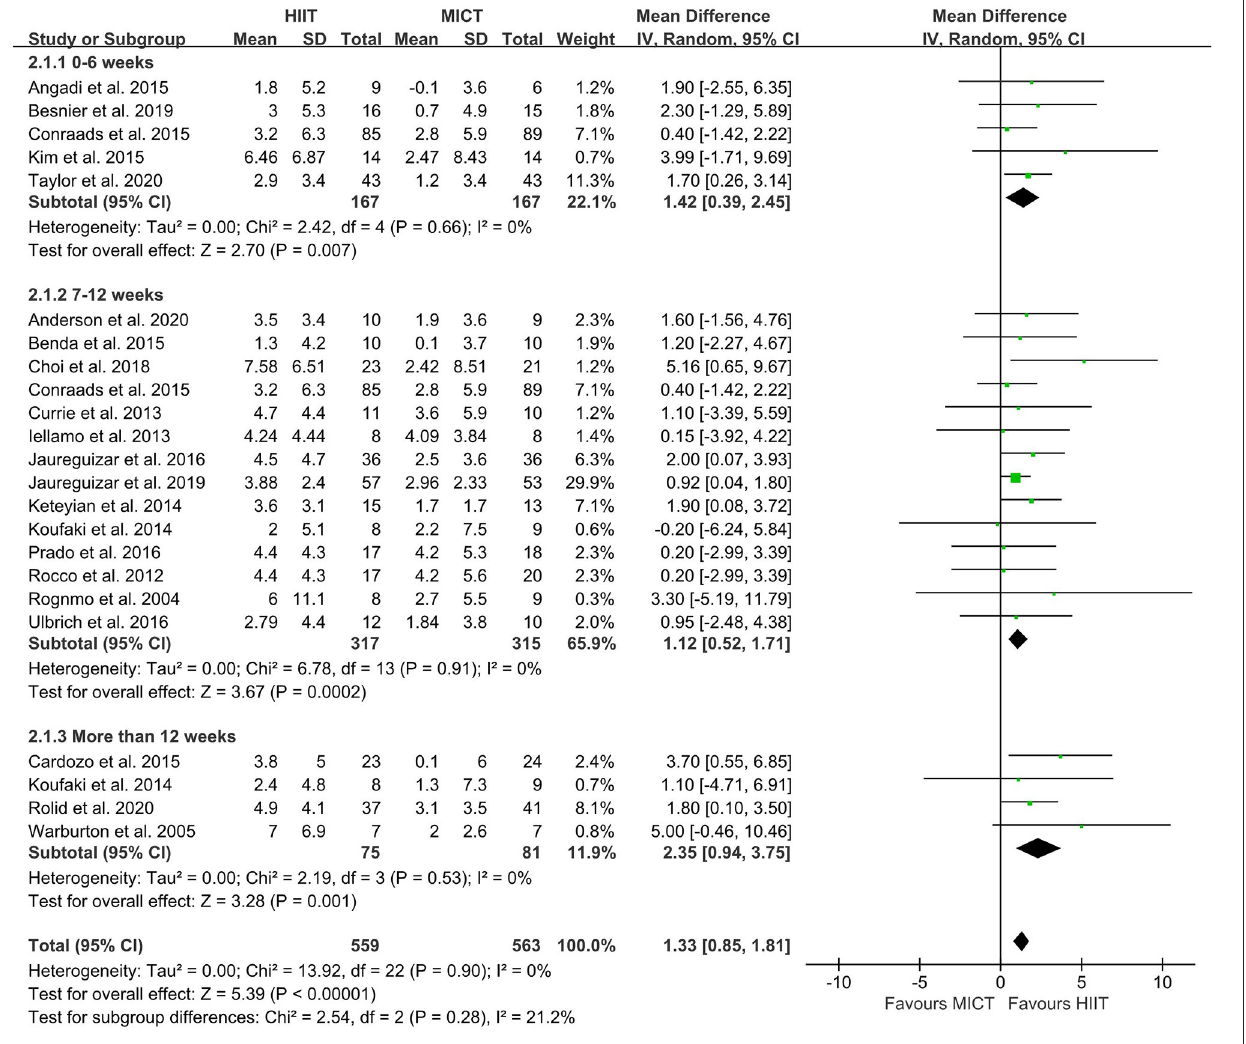
FIGURE 6 | Forest plot of subgroup analysis by different intervention duration (0–6 weeks, 7–12 weeks, more than 12 weeks). HIIT, high-intensity interval training; MICT, moderate-intensity